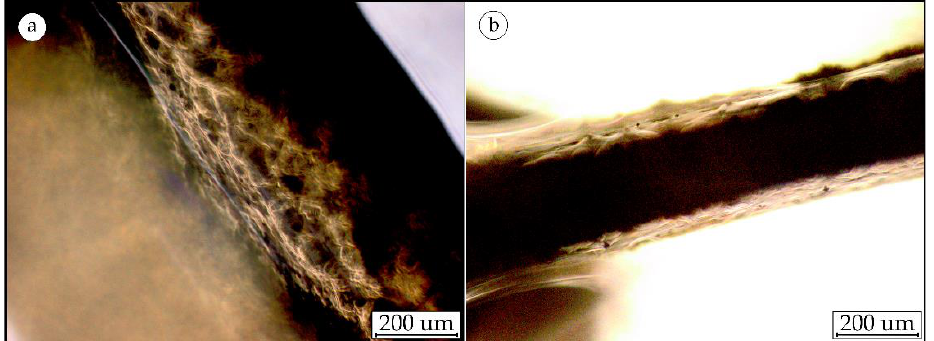
Figure 8. Microscopic images of the biofilm on the PE10 biofilm carriers, sampling position upper layer ( a ) on day 102, ( b ) on day 257. layer ( a ) on day 102, ( b ) on day